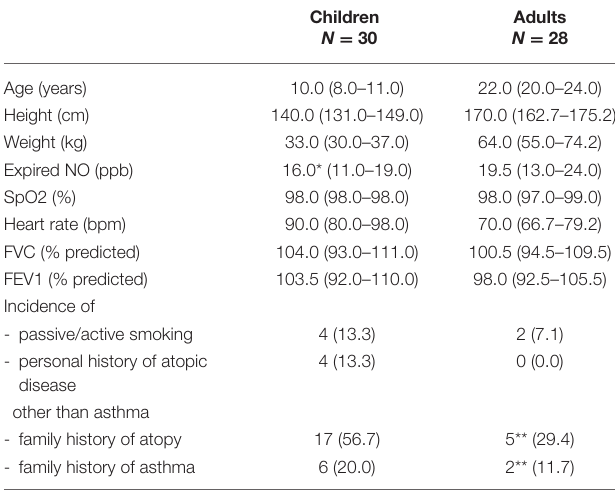
TABLE 1 | Subject characteristics and spirometry at